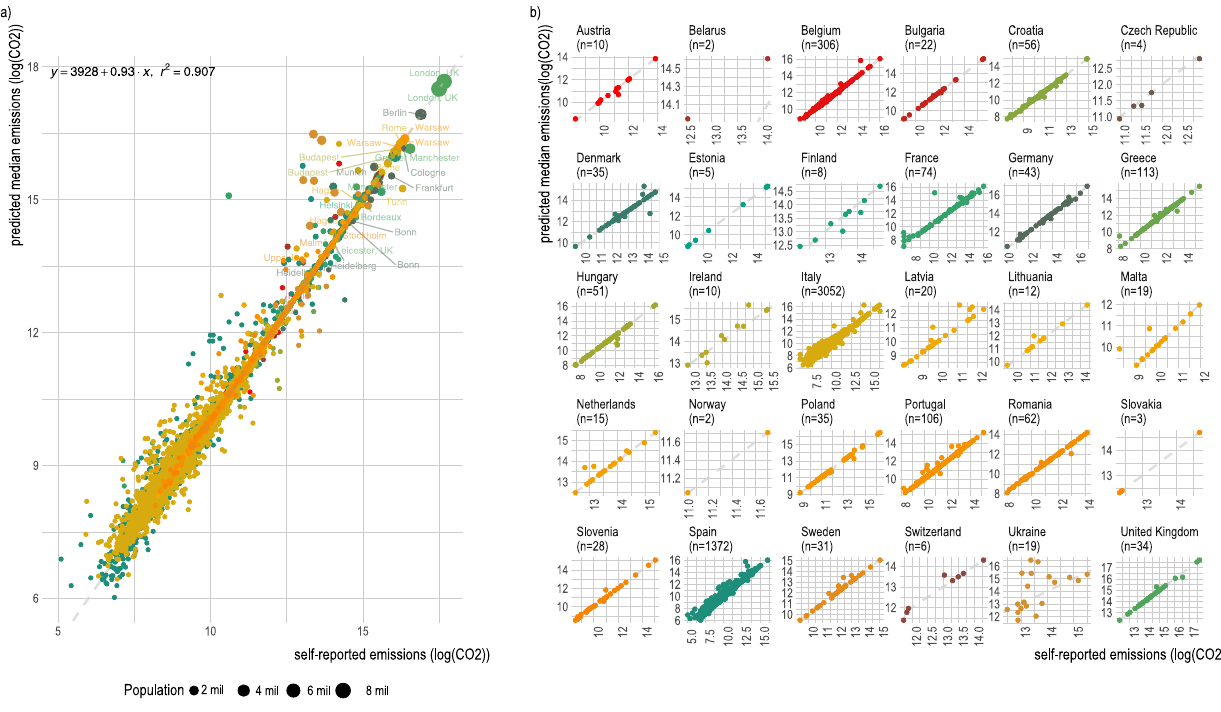
Fig.2|Predictedemissionscomparedtoself-reportedemissions. Scatterplotof self-reported emissions ( n =6961 self-reported emissions data-points from cities reporting to the EUCoM used in the model training) compared to the predicted median emissions for each actor from the modelon a logscale. a All self-reported emissionsinventories(inlogtonsCO 2 )ofallactorsversusthepredictedemissions